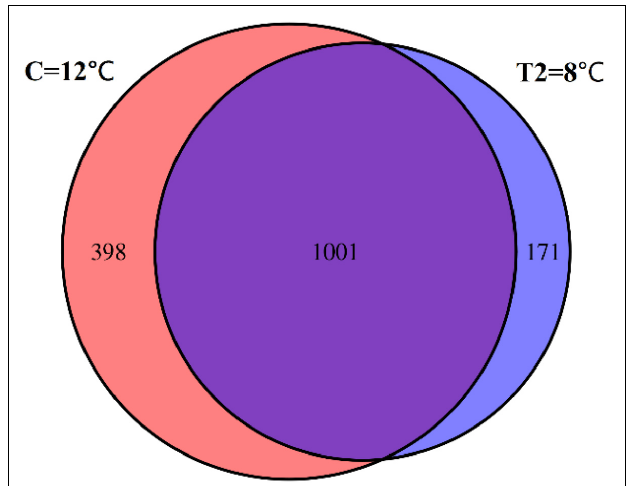
FIGURE 5 | Venn diagram showing the unique and shared OTUs in the control group (C) and the T2 group (T2). The number of OTUs in group C is 1,399. The number of OTUs in group T is 1,172. The number of OTUs shared between groups C and T2 is 1,001. The total richness for all groups is 1,570.